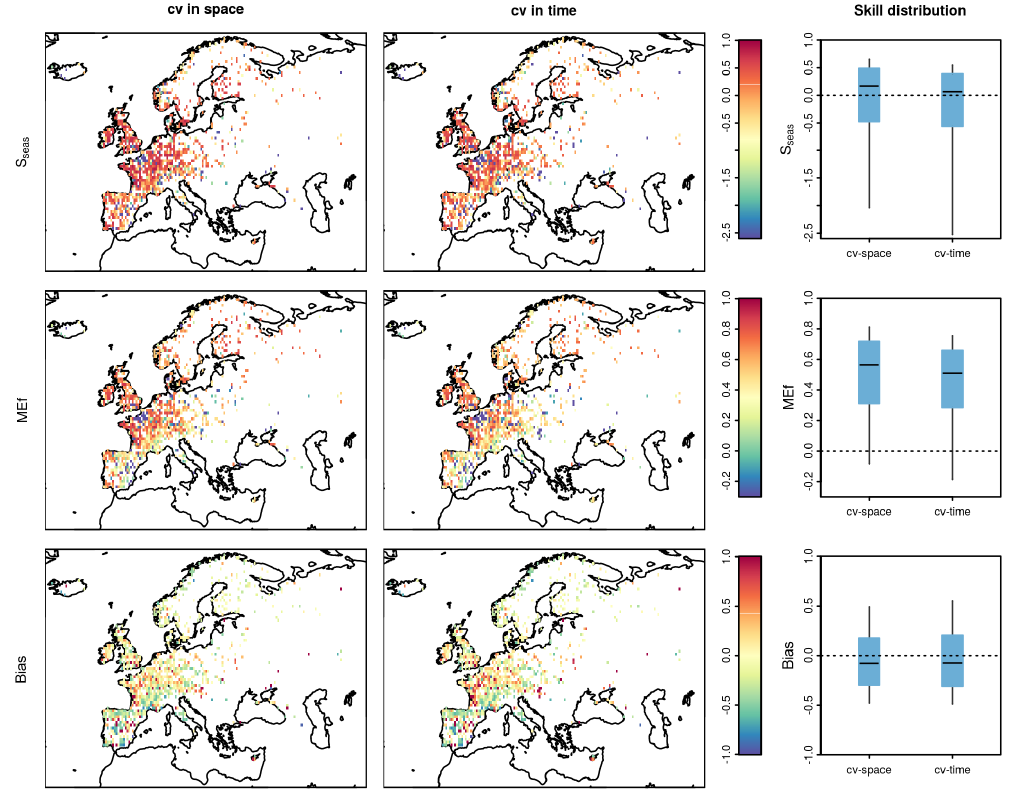
Figure 10. Spatial distributions and box plots (whiskers: 10th and 90th percentiles; box: interquartile range; bar: median) of S seas , MEf and BIAS for both cross-validation